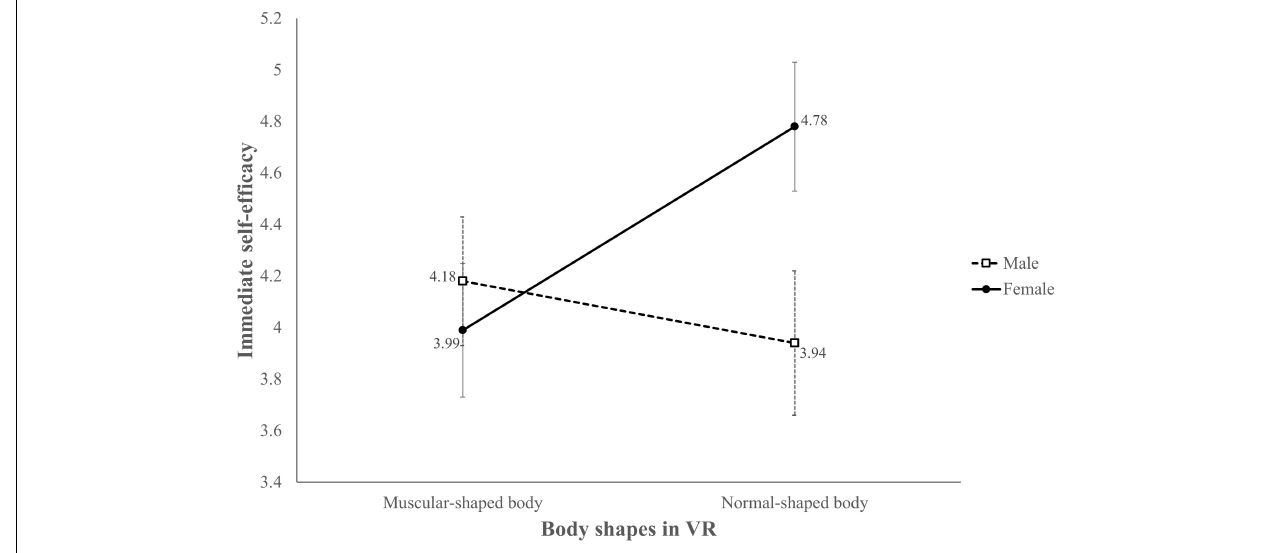
FIGURE 5 | Adjusted mean score of immediate self-efficacy for core